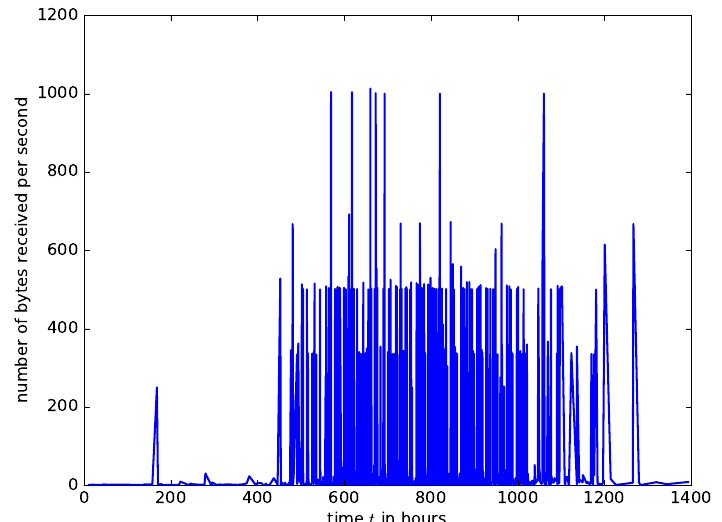
Figure 8. A trace of the arrival intensities of IoT traffic generated using data from a real IoT network, collected in